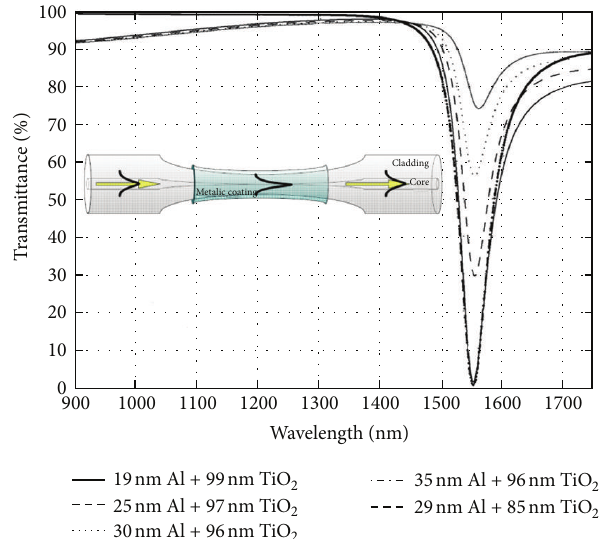
Figure 16: Fibre taper SPR, with different film thickness, showing resonances in the third telecommunication window (taken from [79]).